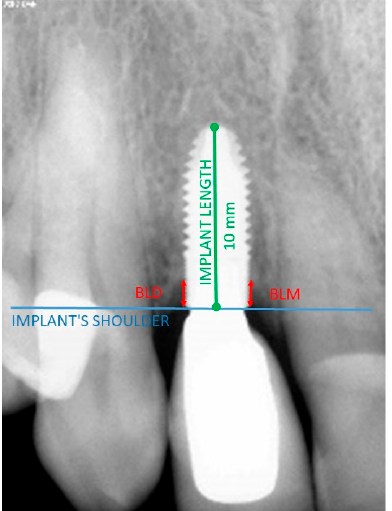
Figure 2. Measurements taken to determine the bone level (BL). Calibration of the program based on implant length and diameter. BLM = mesial bone level, BLD = distal bone level. The B.L. for a given implant and time was calculated as the mean of both measurements (BLM + BLD/2).